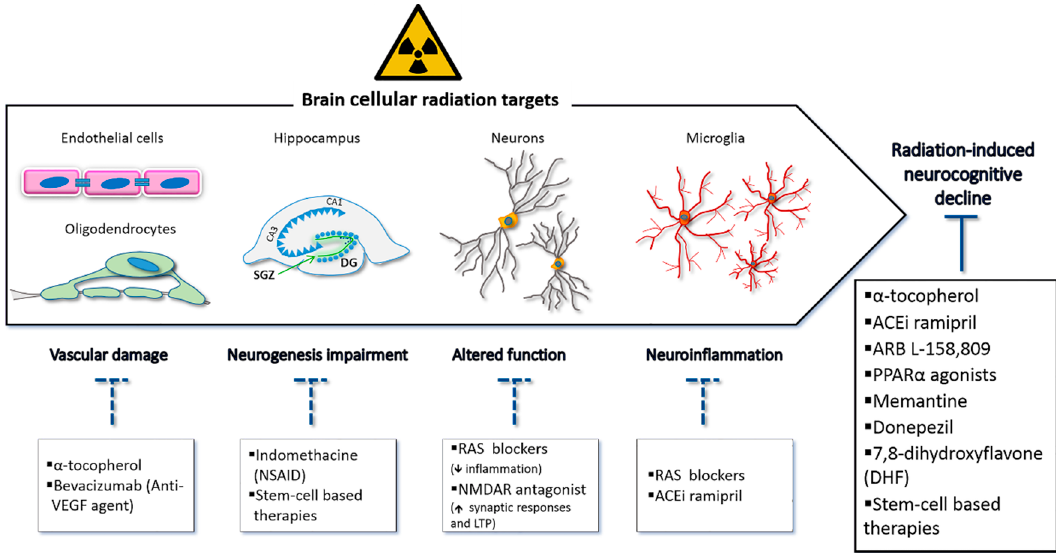
Figure 1. Potential mechanisms triggering radiation-induced cognitive impairment. Brain radiation injury is multifactorial and complex, involving dynamic interactions between multiple cell types. Brain irradiation may cause decline in oligodendrocytes and other glial cells, vascular damage, impaired hippocampal neurogenesis, altered function of adult neurons, and neuroinflammation caused by activated microglia. All these alterations likely contribute to the development of radiation-induced cognitive impairment (upper arrow). Selected strategies to prevent or minimize radiation-induced cognitive dysfunction are shown in the lower boxes, with data derived from both preclinical models and human studies.